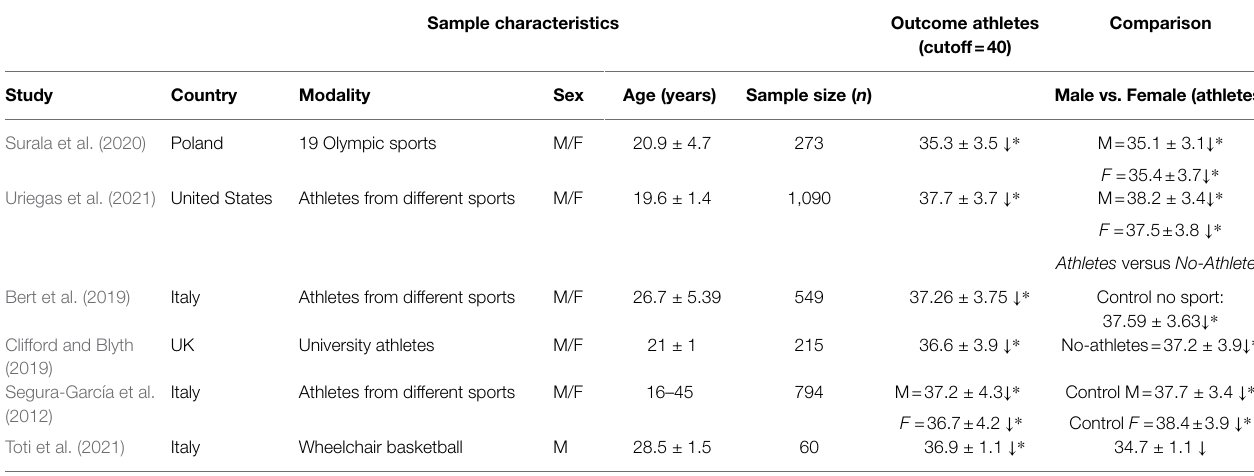
TABLE 1 | Characteristics of the included studies and relevant